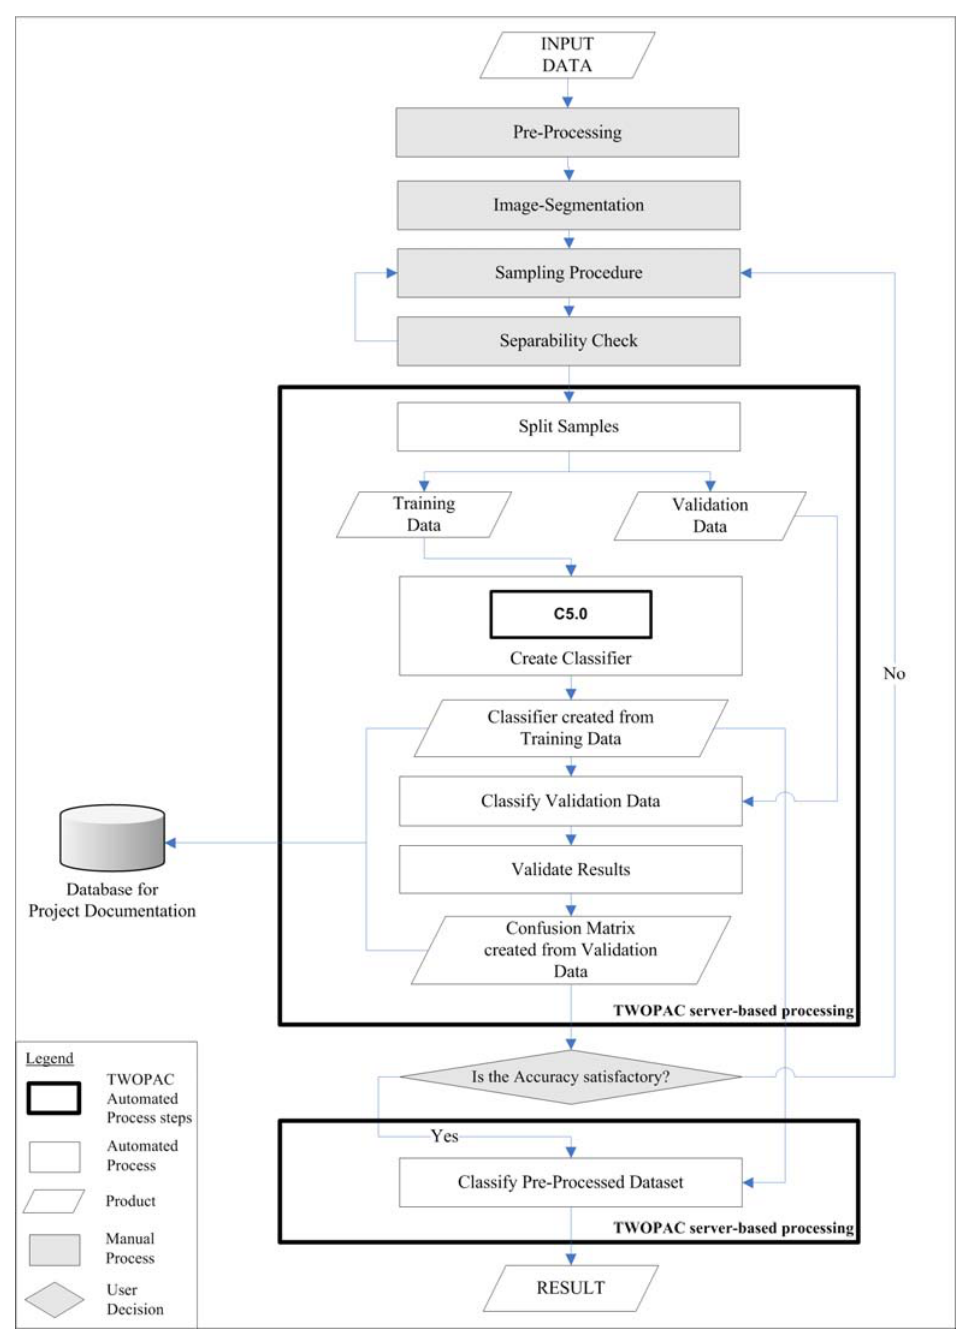
Figure 1. Flowchart of the Twinned Object- and Pixel based Automated classification Chain